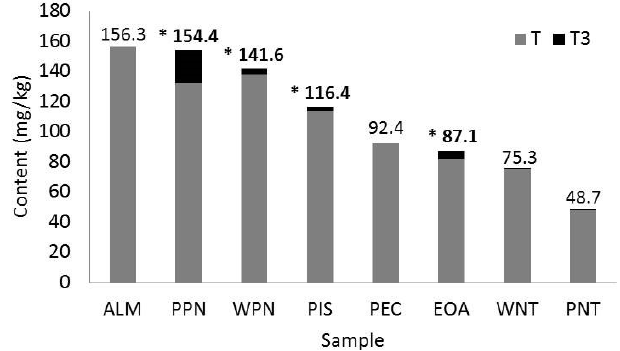
Figure 3. Tocols in edible nuts. Tocopherols (T), tocotrienols (T3), selected edible nut for in vitro peanut (PNT), pink pine nut (PPT), walnut (WNT), and white pine nut (WPM). Table 1. Tocol isoforms in edible nuts 1 .